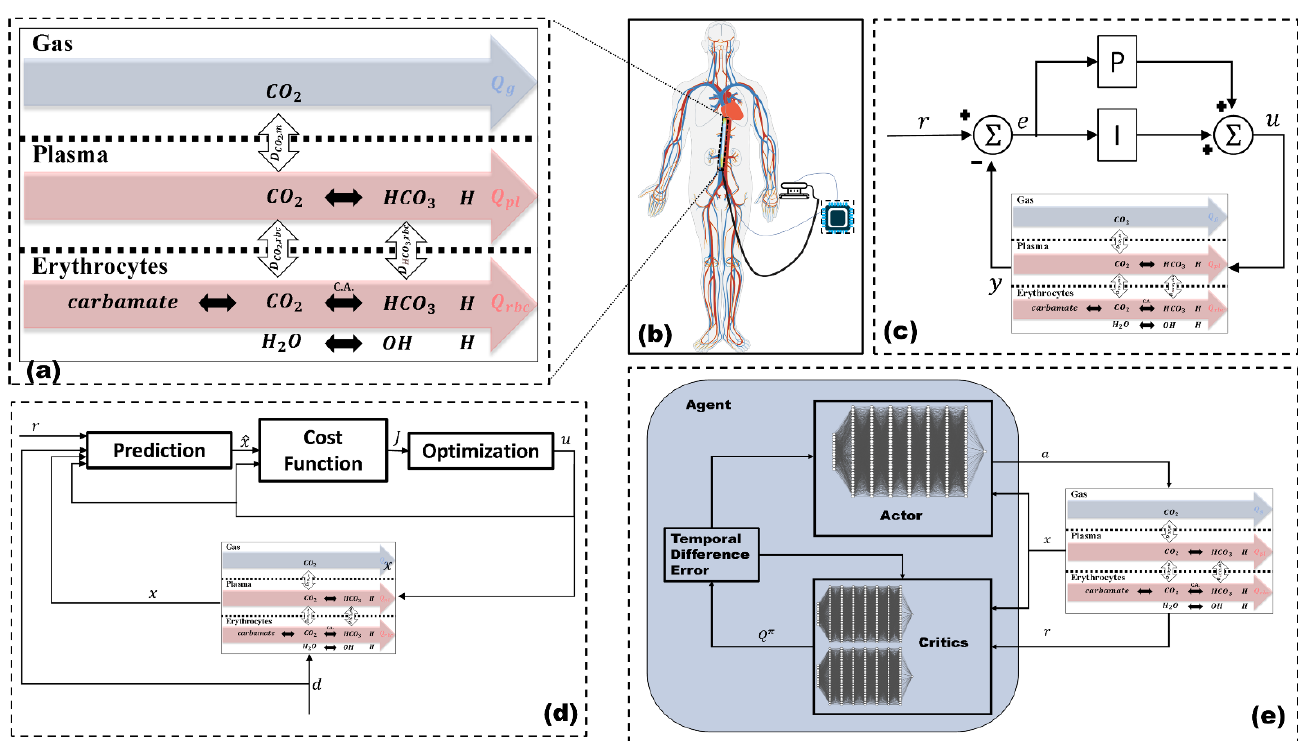
Figure 1. An overview of the system and controllers: ( a ) A schematic representation of the compart- mental model of the membrane oxygenator; ( b ) A drawing of the physical system. The catheter— membrane oxygenator and blood pump—is inserted in the vena cava superior. The extracorporeal part of the device-controller and a compressor are worn by the patient; ( c ) A schematic representa- tion of the PI controller; ( d ) A schematic representation of the NMPC controller; ( e ) A schematic representation of the deep RL controller.